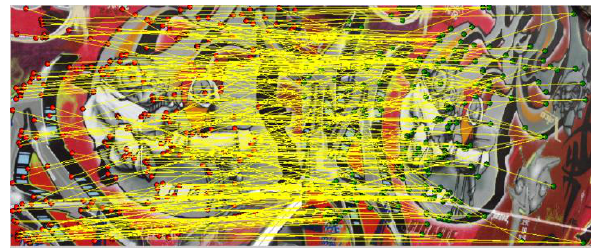
Figure 5. Outlier rejection for the second dataset As can be seen in figure 5(b), the RANSAC algorithm keeps several of the false matches due to their very short distance to the epipolar line, while these outliers are removed in the third step by using the GTM algorithm. Same scenario is shown is figure 6 for the case of planar geometry.